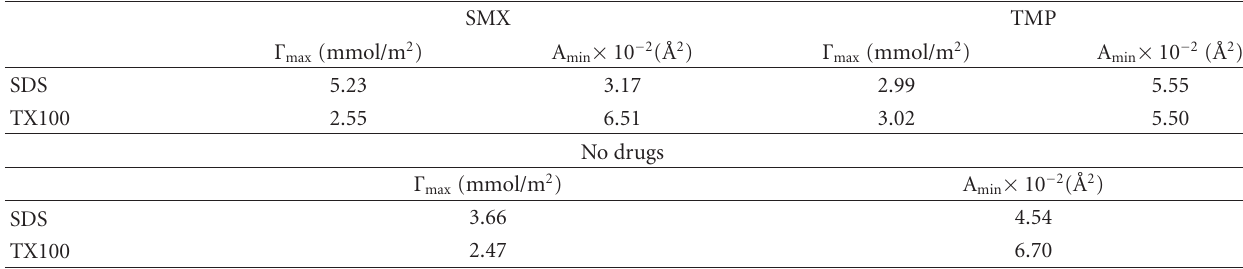
Table 2: Estimated surface excess ( Γ max ) and molecular occupied area (A min ) for SDS and TX100 in the absence and presence of 4 . 0 × 10 − 5 M SMX and TMP at